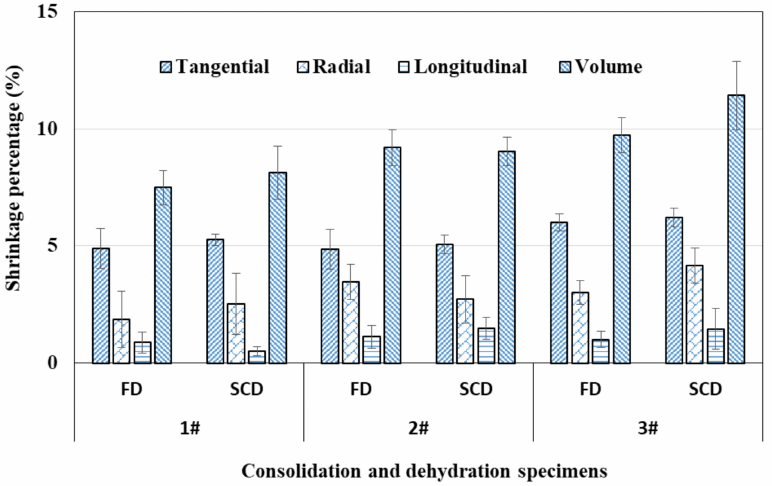
Figure 3. Shrinkage percentage of specimens from different